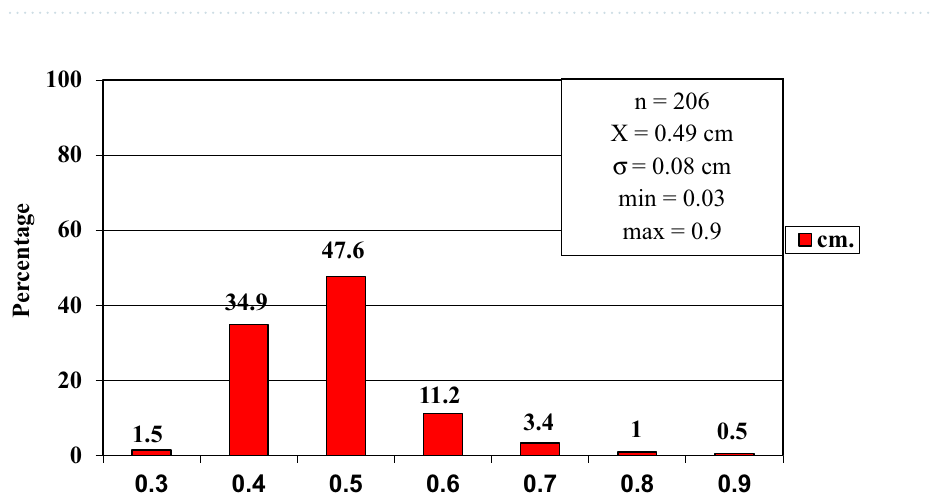
Figure 3. Diameter of the external carotid artery. cm. centimetre, n sample size, X mean, σ standard deviation, min minimum value and max maximum